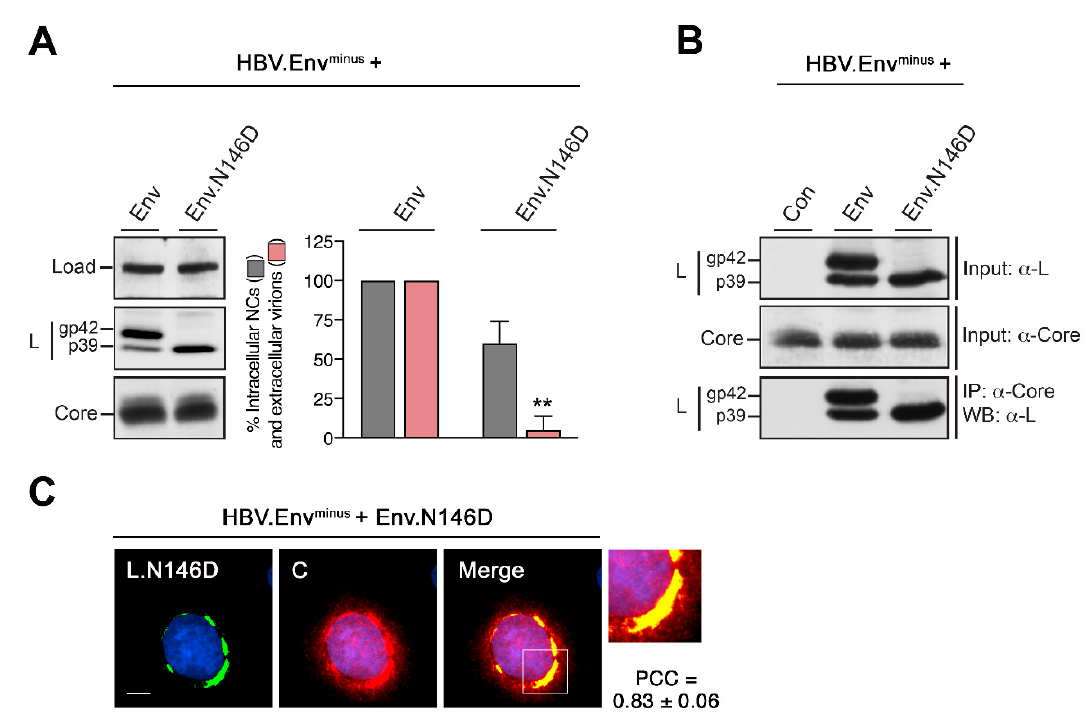
Figure 6. Abrogation of N146-linked glycosylation inhibits HBV release without affecting L/core interaction. ( A ) HuH-7 cells were cotransfected with the envelope-defective HBV replicon (HBV.Env minus ) complemented with expression constructs encoding the wt envelope (Env) or mutant Env.N146D proteins. Three days post-transfection, cellular lysates and supernatants were subjected to L- and core-specific WB analysis and to the virion production assay ( n = 3, ± SD). ( B ) HuH-7 cells were transfected with HBV.Env minus together with control plasmids (Con), the wt envelope (Env) or mutant Env.N146D constructs. To verify equal protein synthesis, lysates were examined with anti-L (K1350) and anti-core (K46) antibodies. For CO-IP analysis, lysates prepared with CHAPS were reacted with anti-core antibodies (K45) followed by L-specific (MA18/7) WB. ( C ) HuH-7 cells, cotransfected with HBV.Env minus and the mutant Env.N146D expression construct, were processed for immunofluorescence (IF) and stained with anti-L (57761, L, green) and anti-core (B0586, C, red) antibodies. An overlaid image is displayed in the Merge panel, with an outlined area shown at larger magnification. For QCA, PCC values were calculated and represent the mean ± SD. Bar, 10 µM. 3.7. HBV L Interacts with ERGIC-53 in a N146-Glycan-Dependent Manner